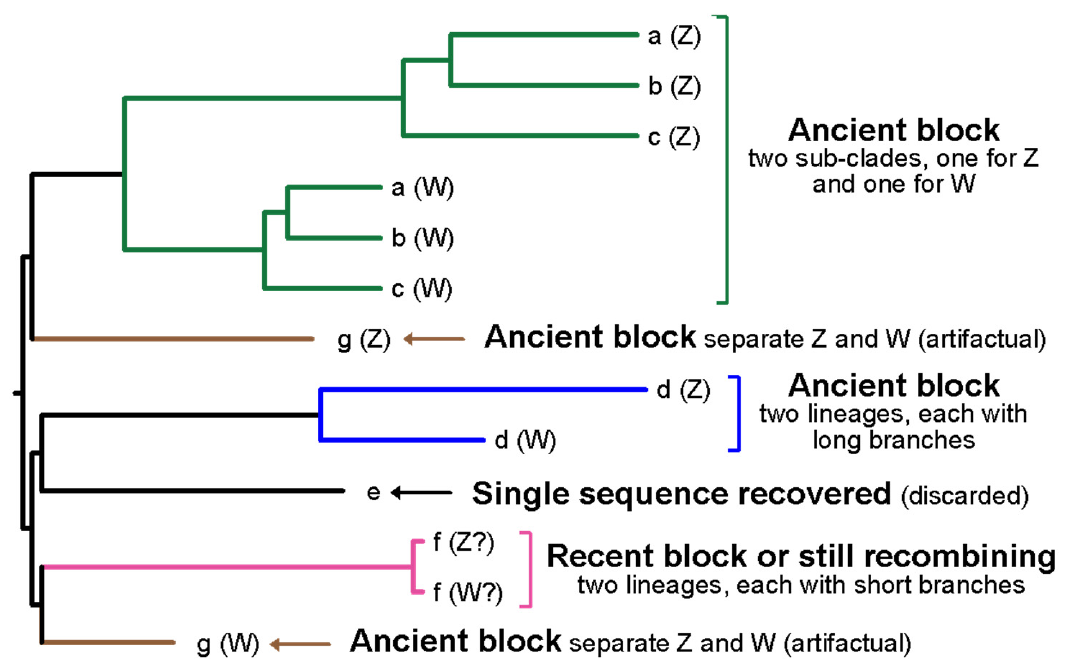
Figure 2. Interpretation of results to assess when there have been barriers to recombination. For taxa a, b, and c, there was a barrier to recombination prior to the divergence of these three taxa. For taxon d, there has been a barrier to recombination but it is not shared with other taxa. For taxon e, only one sequence was identified, so sample not included in final analyses. For taxon f, it is not clear if